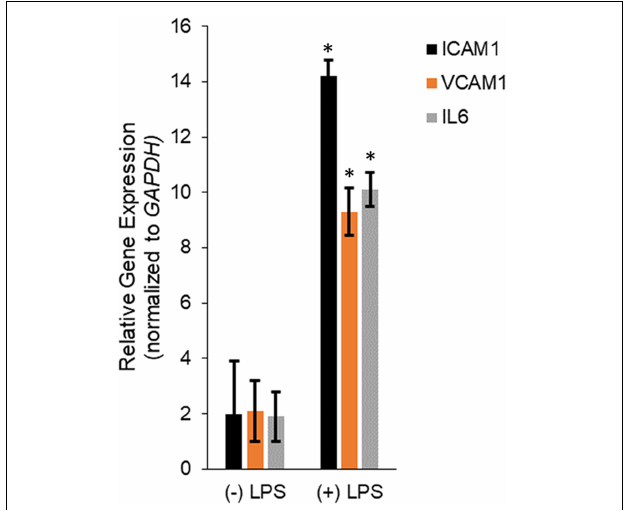
FIGURE 1 | Transcription of IL6 , ICAM1 , and VCAM1 encoding interleukin-6, intercellular adhesion molecule-1, and vascular cell adhesion molecule-1, respectively, were upregulated during LPS induced sepsis. Expression of ICAM1 , VCAM1 , and IL6 mRNAs were determined by qRT-PCR in untreated or LPS-treated HMECs. Data represent mean ± standard deviation of three independent experiments, post-normalization to GAPDH expression. ∗ P < 0.05, compared to untreated